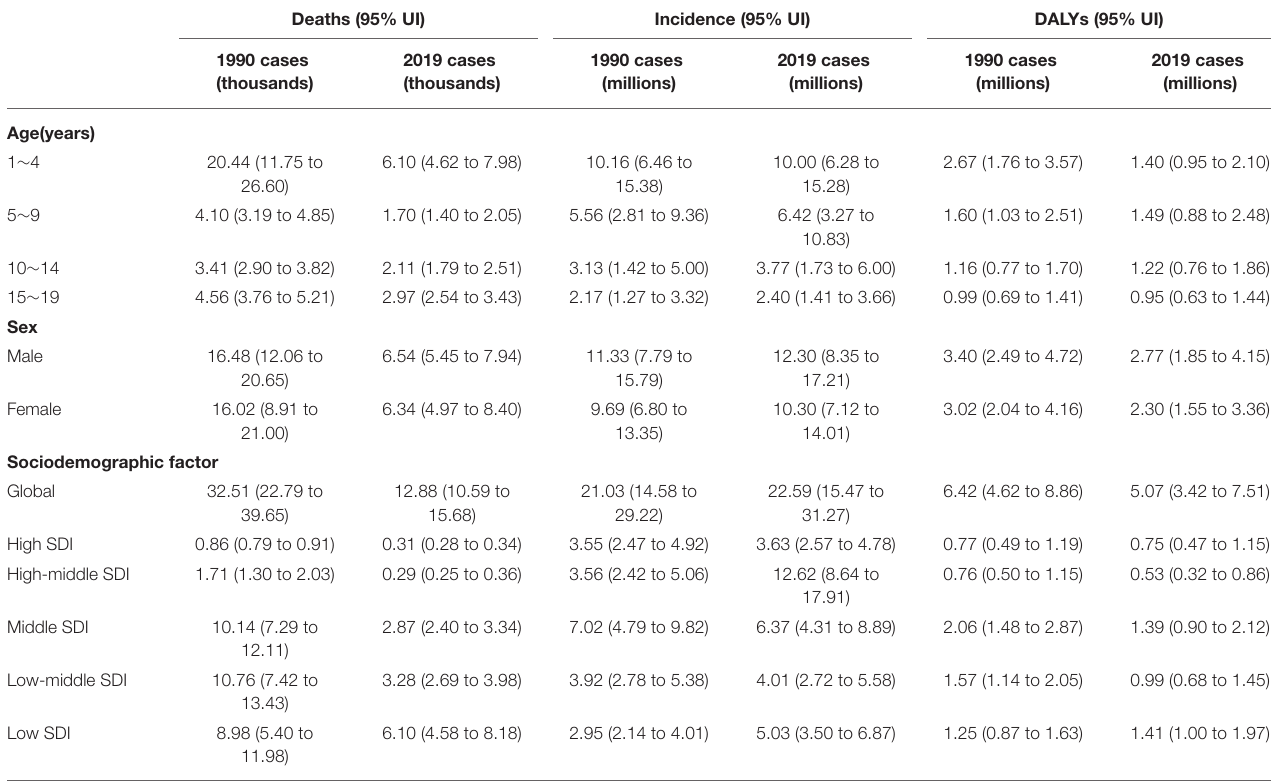
TABLE 1 | The burden of childhood asthma by age group, sex and SDI in 1990 and